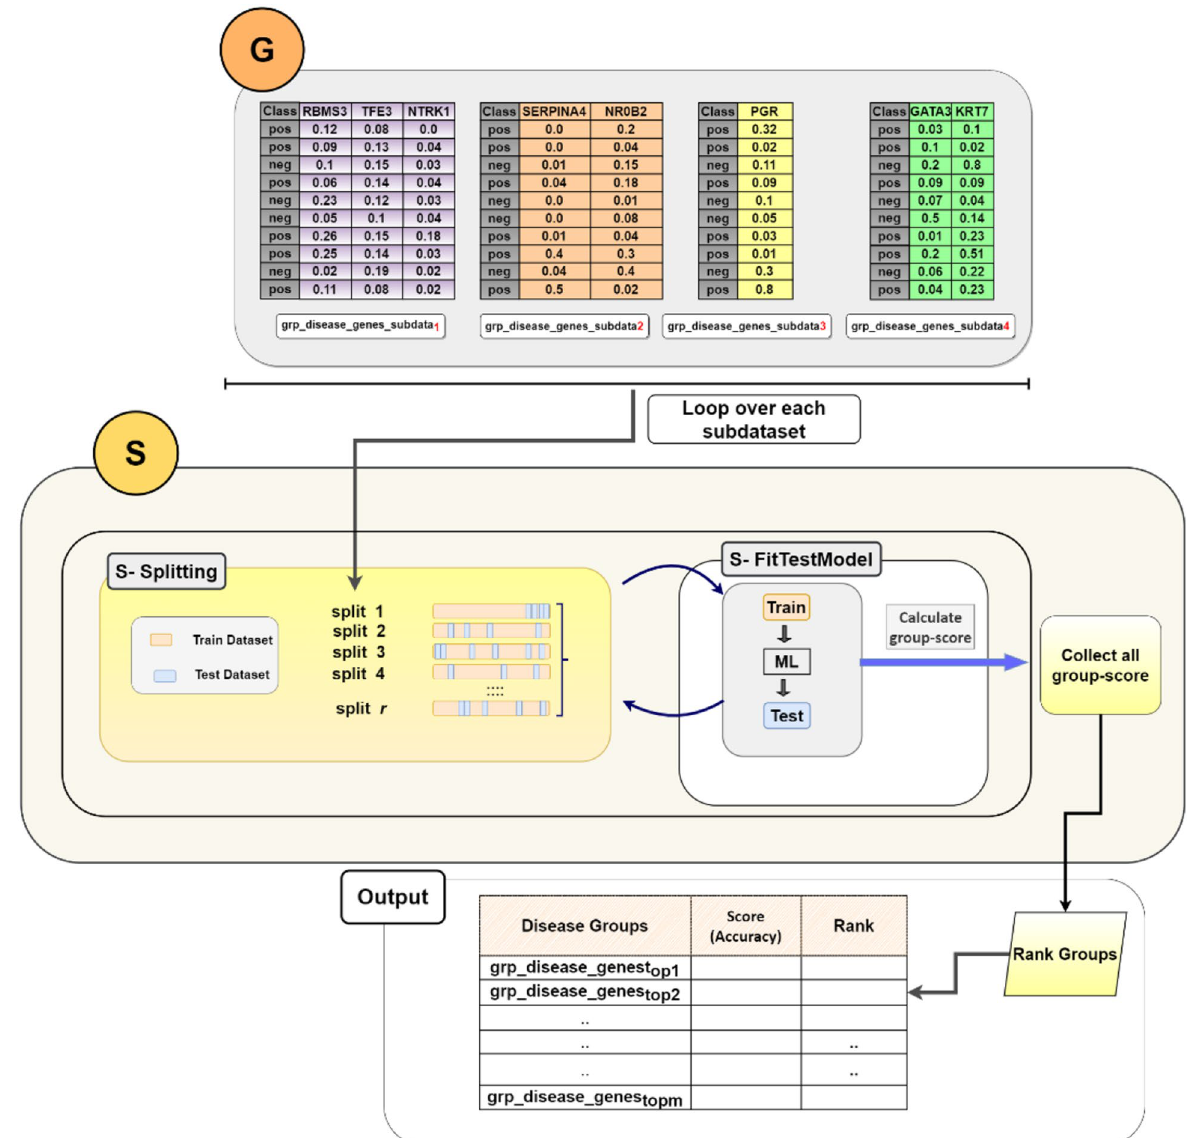
Figure 5. The details of the S component. The G panel contains all the two-class sub-datasets that each one is subject to the S